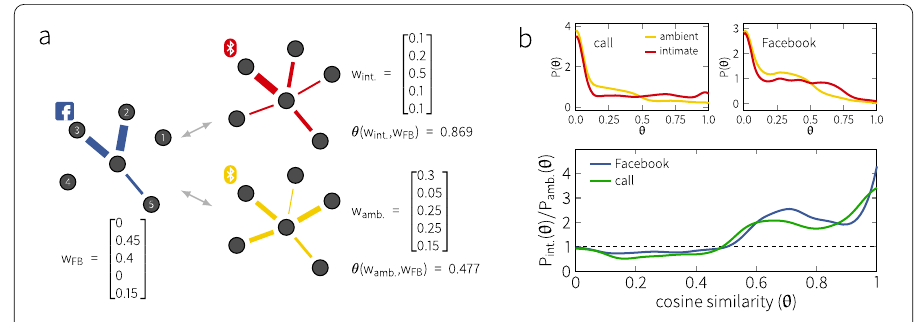
Figure 2 Structural similarity of the physical proximity and communication networks. (a) Illustration of neighbor cosine similarity between networks. (b) Distribution of cosine similarity between the intimate network and communication networks. Proximity networks are compared to calls (left) and Facebook interactions (right). On the bottom, the pointwise ratio of the intimate and ambient distributions are reported. Data is binned and a kernel-density smoothing is